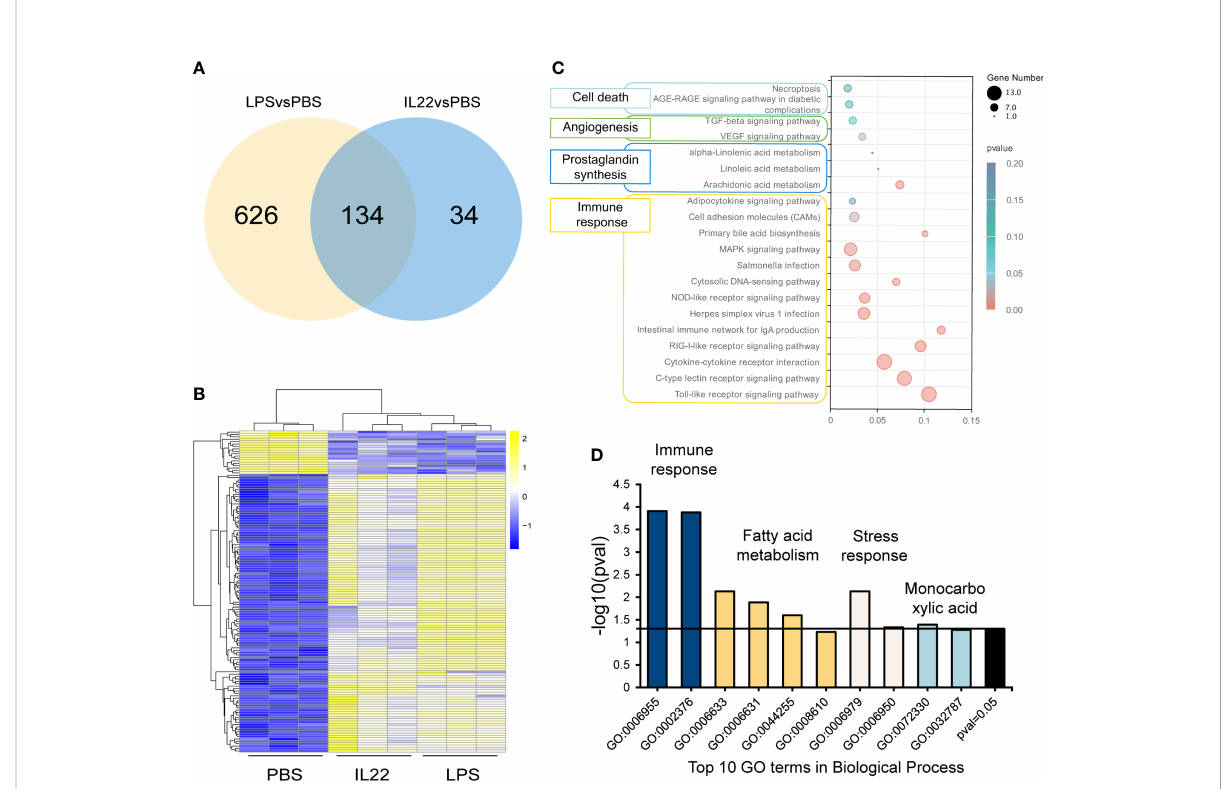
FIGURE 5 (A) Venn diagram of the DEGs of LPS vs PBS group and IL-22 vs PBS group. (B) Heatmap of 134 DEGs in the three groups (PBS, LPS, and IL-22). Yellow and blue colors indicated up- and down-regulated transcripts, respectively. (C) KEGG analysis of the 134 DEGs. Enriched pathways were classi fi ed into four classi fi cations including Immune response, PG synthesis, Angiogenesis, and Cell death. (D) The top 10 GO terms of the 134 DEGs were classi fi ed into Immune response, Fatty acid metabolism, Stress response, and Monocarboxylic